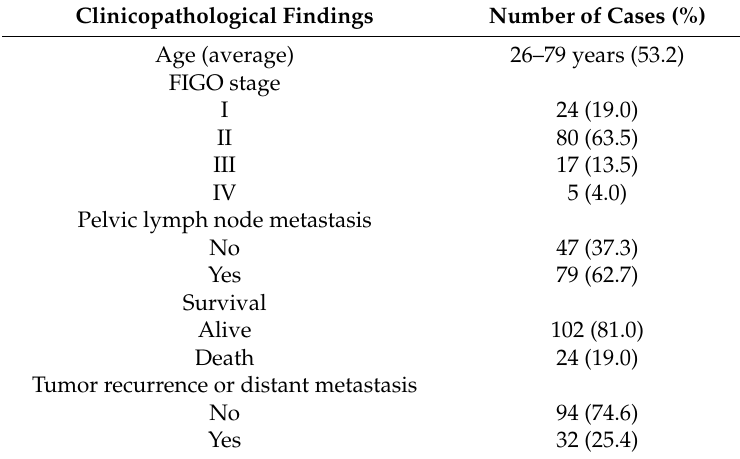
Table 1. Clinicopathological characteristics of the 126 patients with cervical cancers.